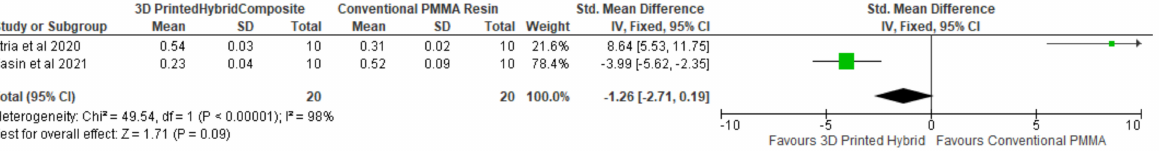
Figure 10. Forest plot comparing the surface roughness between 3D-printed hybrid composite resin and conventional PMMA resin.